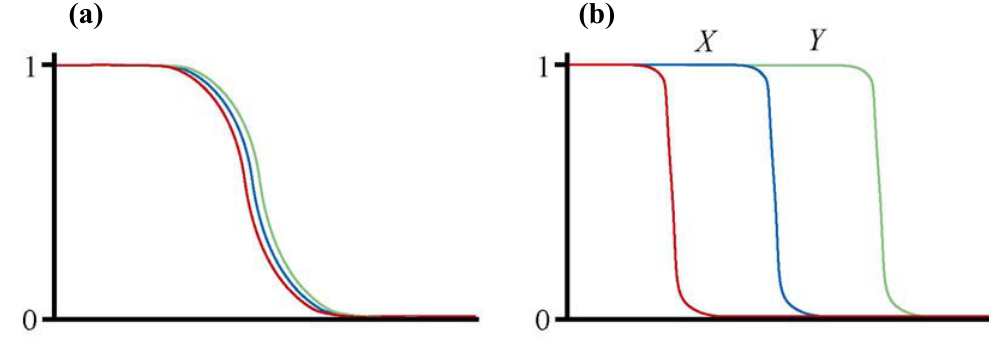
Figure 1. Diagrams illustrating the difference between a hybrid zone with coincident (a) and staggered (b) clines. In each graph the x axis represents geographic distance along a transect across the hybrid zone and the y axis represents frequency. Each coloured line represents the cline for a different genetic character. See text for further